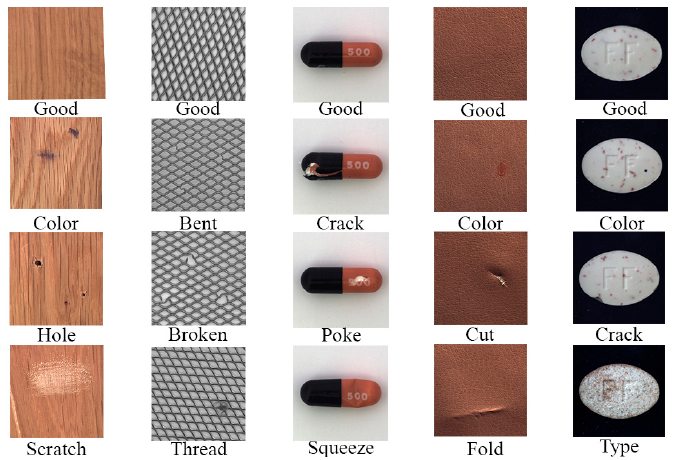
Figure 1. Normal samples of industrial products are compared to defective samples. The first row contains good samples, and the second, third, and fourth rows contain defective samples. The first, second, third, fourth, and fifth columns display wood, grid, capsule, leather, and bill, respectively, and there are three types of defects listed below the image.